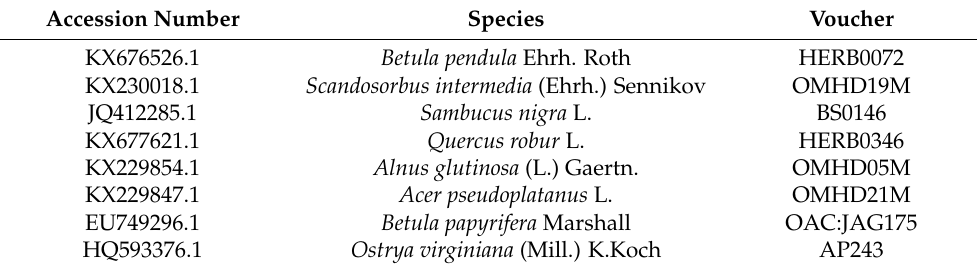
Figure 7. Comparison of phylogenetic reconstruction of the sampled tree species using the matK chloroplast gene ( A ) and the sample groupings from the PLS analyses at the host tree family level ( B ) and the host tree species level ( C ). Host tree families have been colored for clarity, and the sample countries have been barcoded to identify additional clustering trends. Branch numbers on A represent ultrafast bootstrapping results (1000 replicates). Table 2. Sequence data used for building the phylogenetic